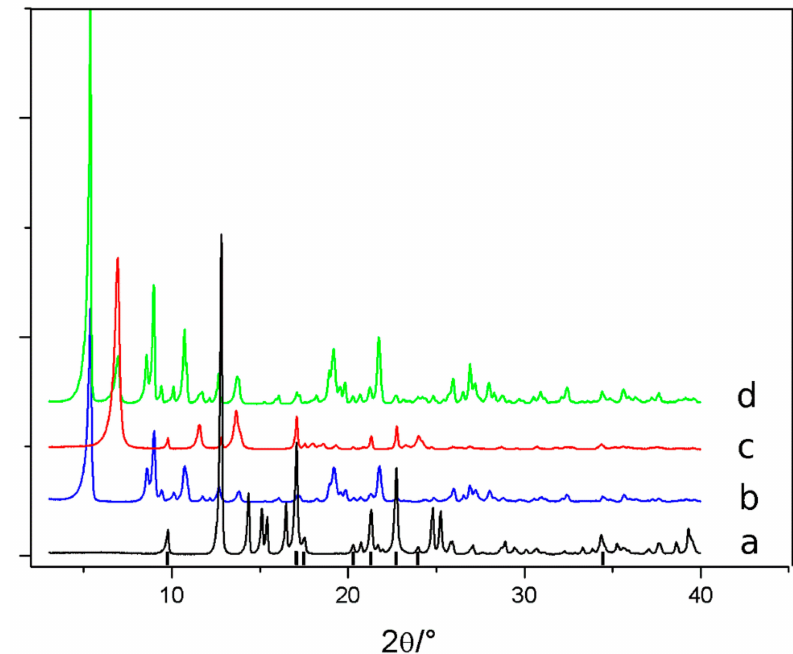
Figure 4. ( a ) Di ff raction pattern of the Cu(CH 3 COO) 2 H 2 O and H 2 pc 2 p mixture, the main H 2 pc 2 p peaks in the bottom spectrum are indicated with black lines; ( b ) di ff raction pattern of pure phase 1 ; ( c ) di ff raction pattern of pure phase 2 after the adding of few drops of water; ( d ) di ff raction pattern of a mixture of 1 and 2 after the adding of 1ml of